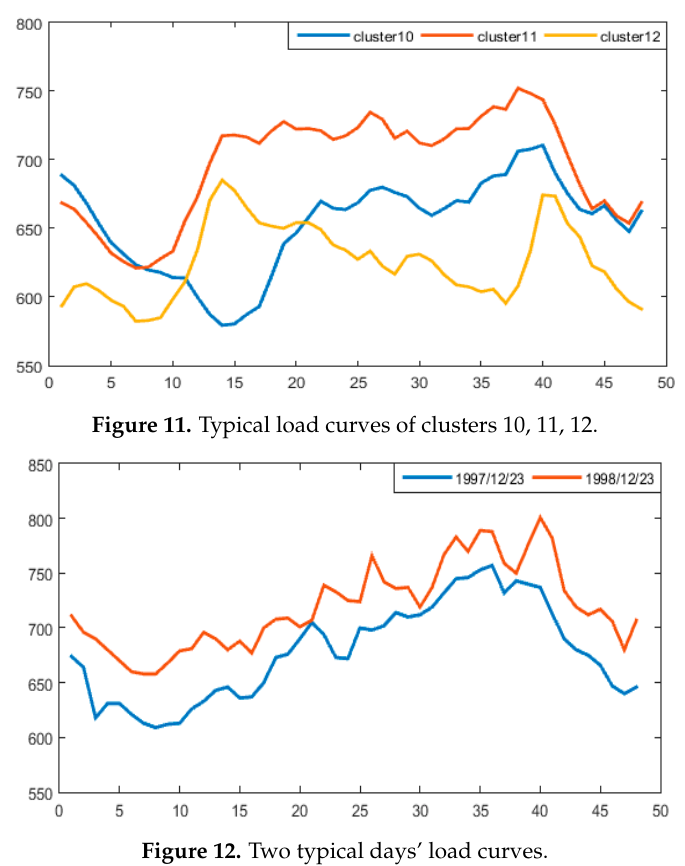
Figure 12. Two typical days’ load curves.